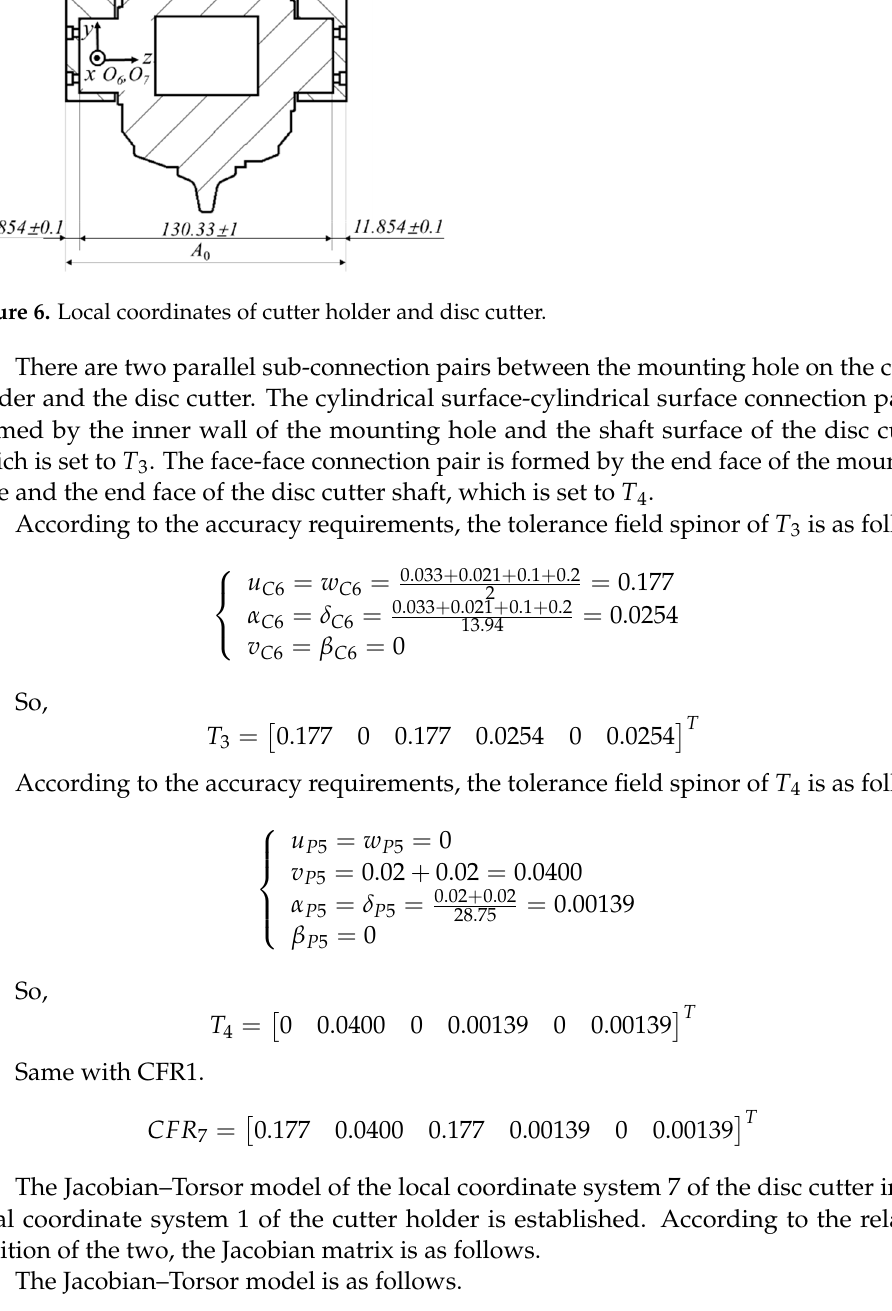
Figure 5. Tolerance of disc cutter and cutter holder. 1—Disc cutter, 2—Cutter holder.